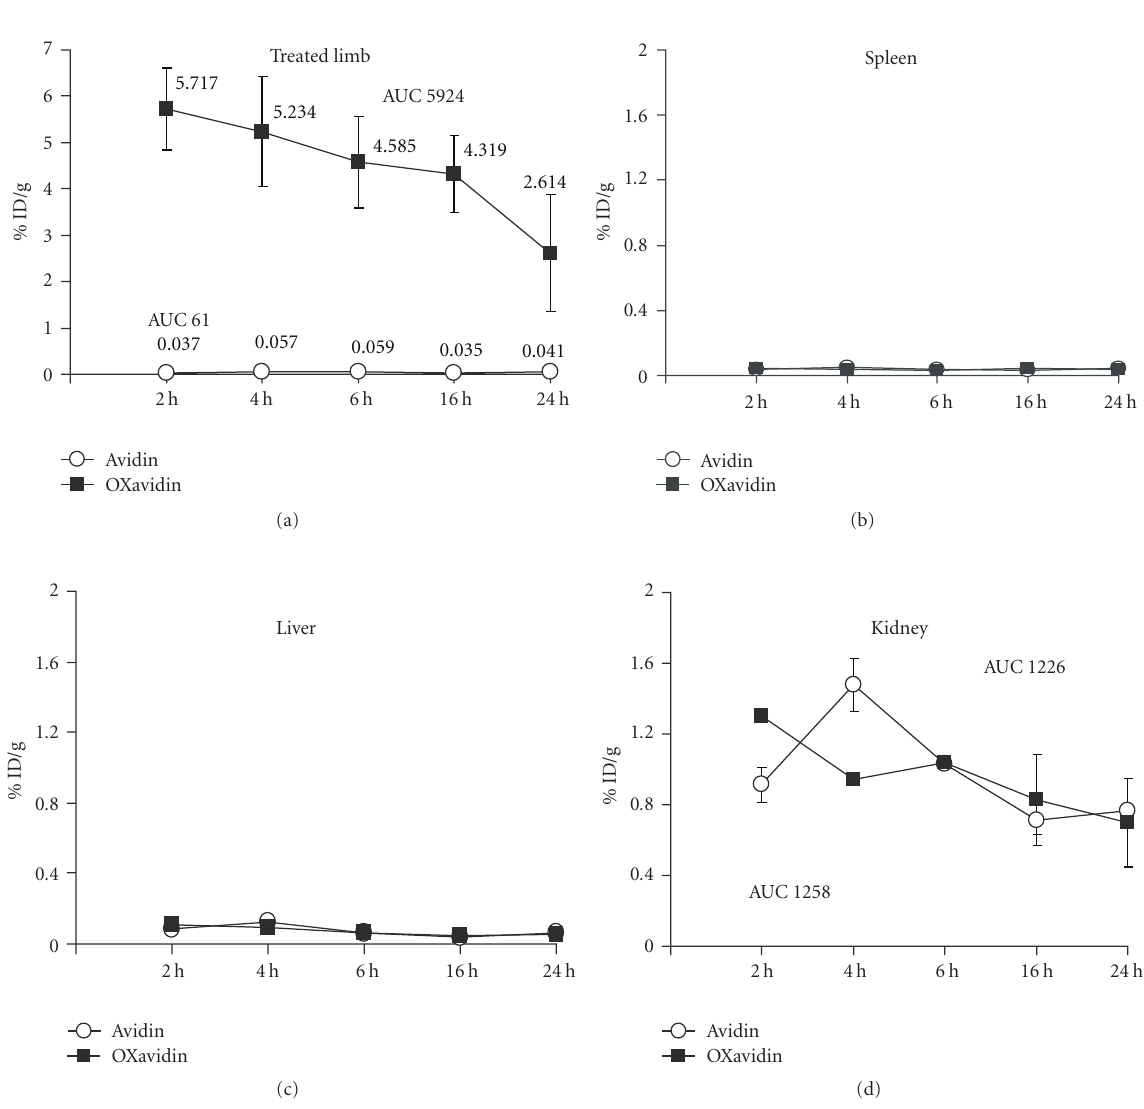
Figure 5: Uptake of 111 In-ST2210, intravenously injected 48 hours after intramuscular administration of OXavidin or avidin in a limb. Groups of mice were sacrificed at the indicated time points after 111 In-ST2210 injection and samples of treated limb, spleen, liver, and kidney weighted and counted in a gamma counter. Data are expressed as % ID/g of tissue. Each point is the average of 5 mice. Bars represent standard